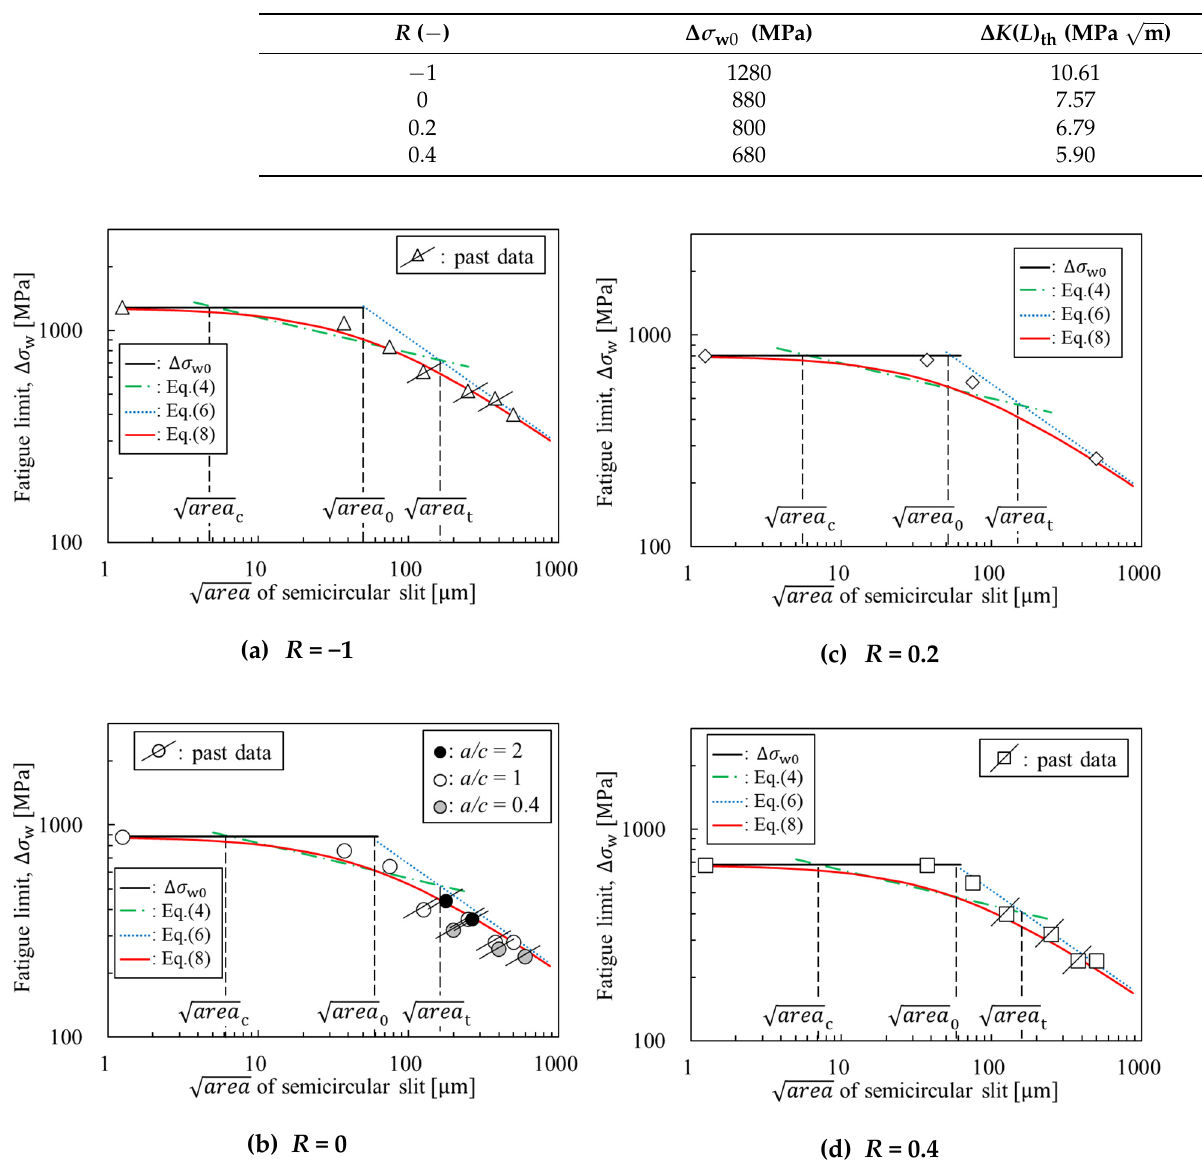
Figure 9. Relationship between the fatigue limit and the 0, ( c ) R = 0.2, ( d ) R = 0.4.